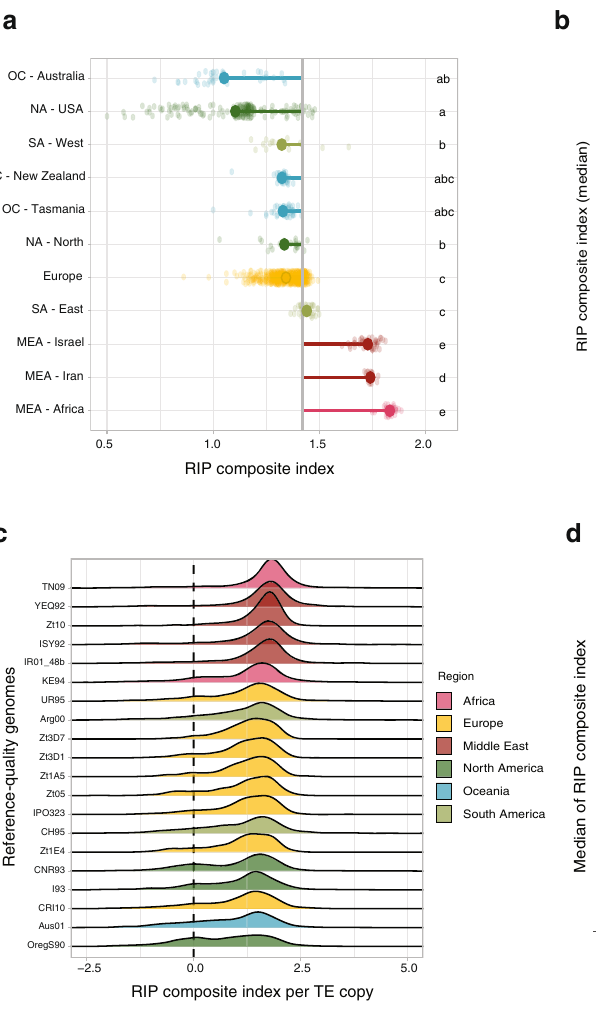
TIPs per genome compared to the median of the RIP composite in reads mapping on TE consensus sequences. The colors/shapes are the same as in panel d . c Distribution of RIP composite index per TE copy in 20 high-quality genome assemblies for the species. The dotted line at value 0 corresponds to no detected RIPsignal. d MedianoftheRIPcompositeindexofthereadsalignedtoaspeci fi cTE consensus as a function of the TE consensus